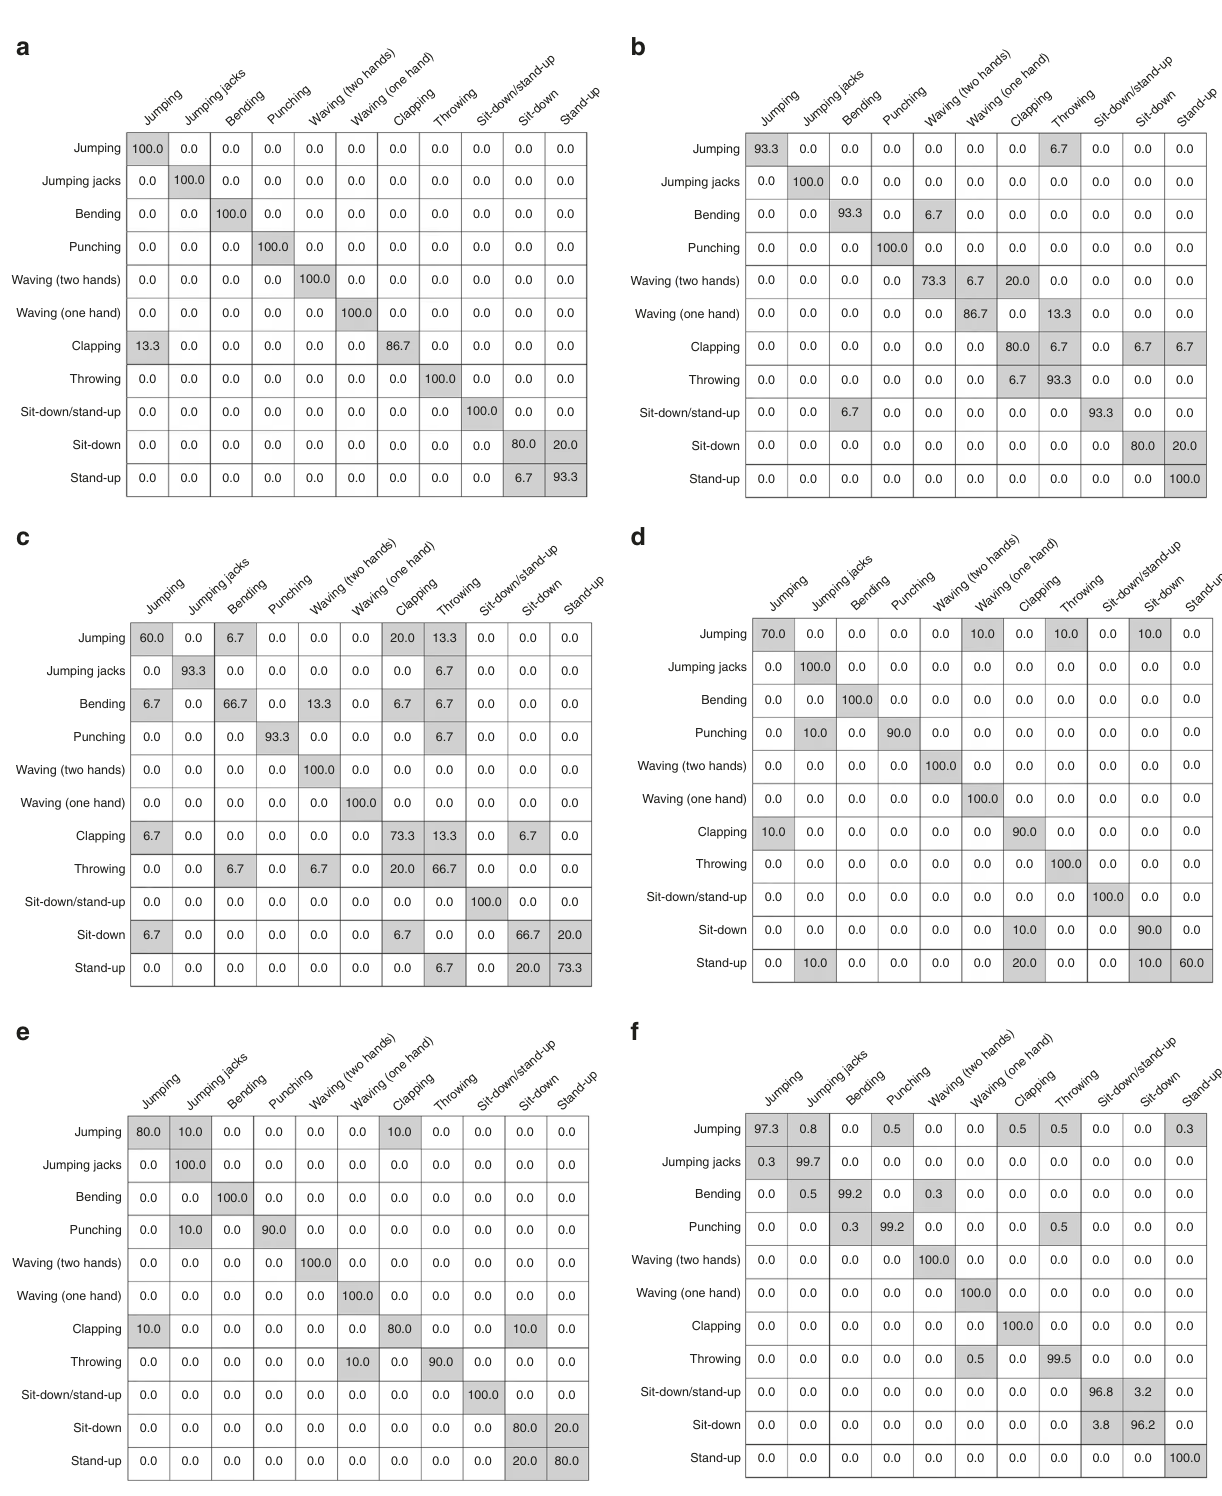
Fig. 5 Confusion matrix for the validation set corresponding to the Berkeley Multimodal Human Action Database (MHAD). The results correspond to a support vector machines (SVM), b K-nearest neighbors (KNN), c decision trees (DT), d random forests (RF), e logistic regression (LR), and f deep long short-term memory (LSTM) recurrent neural network (RNN) classi fi ers. The rows and columns represent the percentage of true activity labels and the predicted activity labels,